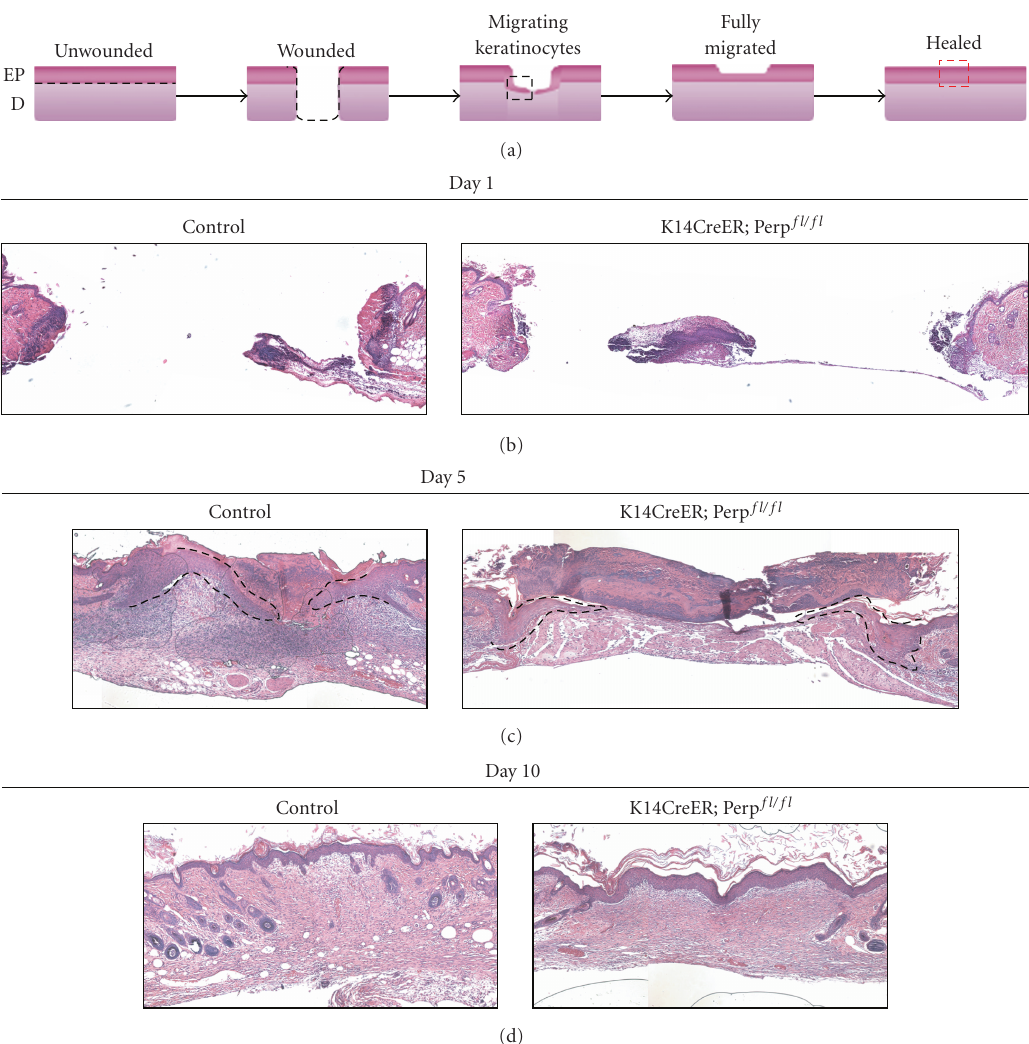
Figure 3: Wounded K14CreER; Perp fl/fl mice exhibit delays in reepithelialization. (a) Cartoon sketch depicting the di ff erent stages occurring during the wound healing process. The black dashed line marks the boundary between the epidermis and dermis. Black dashed box demarcates region with migrating keratinocytes, as shown in panel (c). Red dashed box represents region of fully closed wound, as shown in panel (d). EP signifies epidermis and D, dermis. (b) Representative H&E-stained section of open wounds from tamoxifen-injected control ( Perp fl/fl ) and K14CreER; Perp fl/fl mice 1 day post wounding. (c) Representative H&E-stained section of wounds from tamoxifen-injected control ( Perp fl/fl ) and K14CreER; Perp fl/fl mice 5 days post wounding. The migrating epithelial sheets are outlined by the black dashed line. (d) Representative H&E-stained section of closed wounds from tamoxifen-injected control ( Perp fl/fl ) and K14CreER; Perp fl/fl mice 10 days post wounding. Sizes of boxes in (b) and (c) were determined by the edges of the wound, as marked by the panniculus